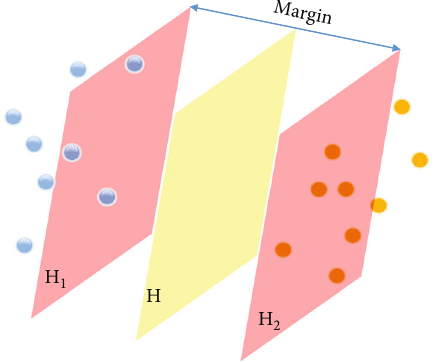
Figure 5: The hyperplane of the support vector